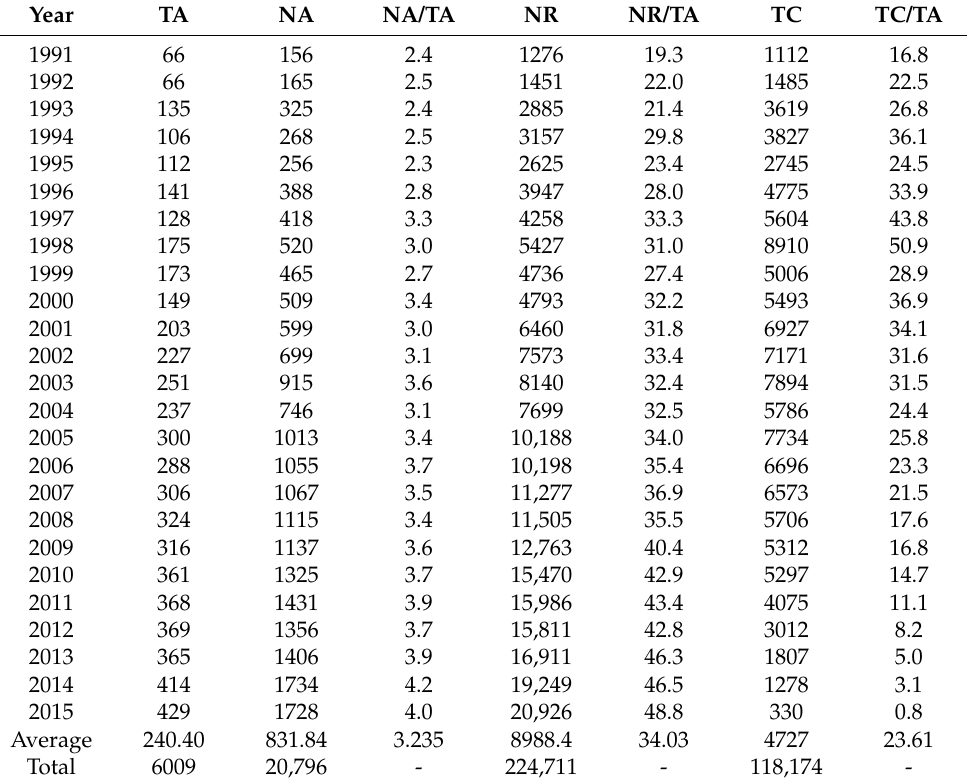
Table 1. Scientific outputs on NPS from 1991 to